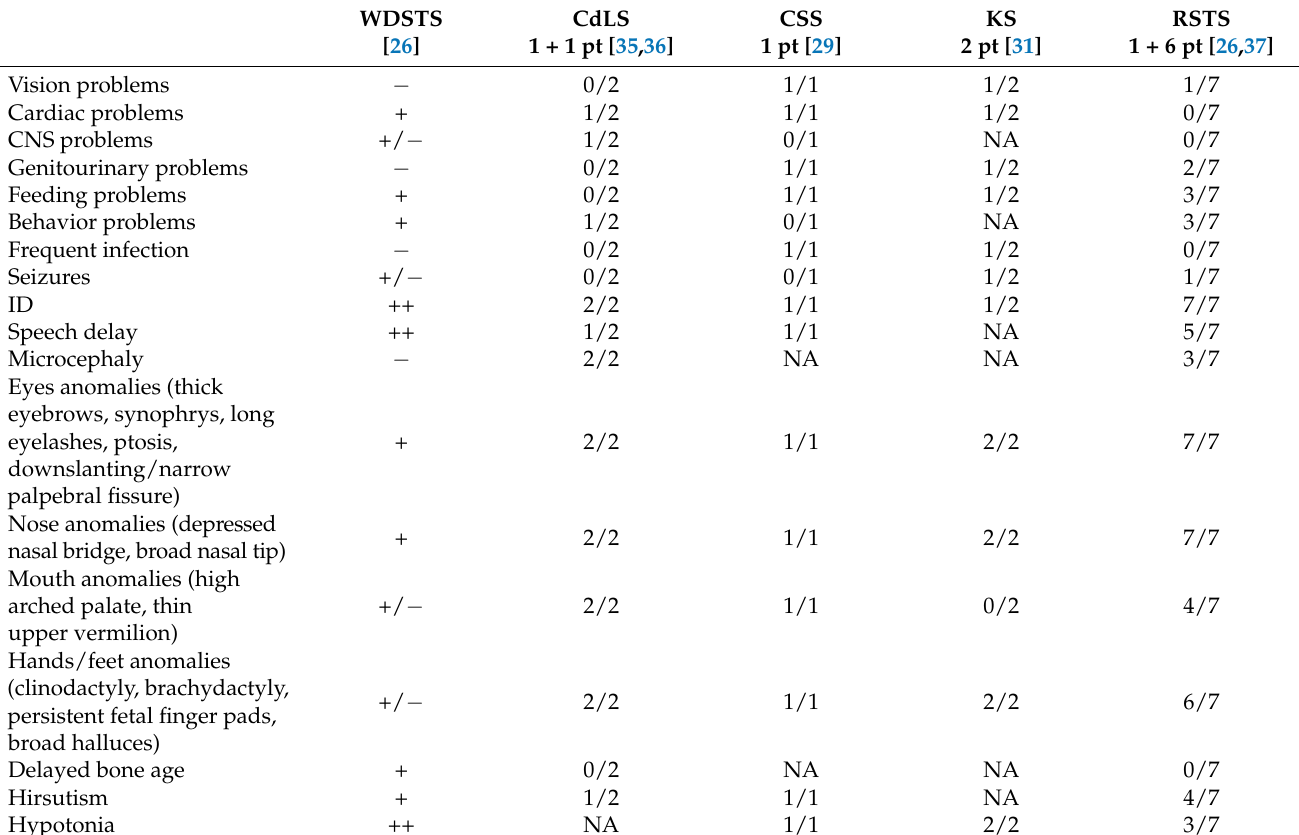
Table 2. Clinical signs reported in patients with a KMT2A mutation and an initial clinical diagnosis of chromatinopathy. Presence of all features is compared with the one in WDSTS. WDSTS CdLS CSS KS